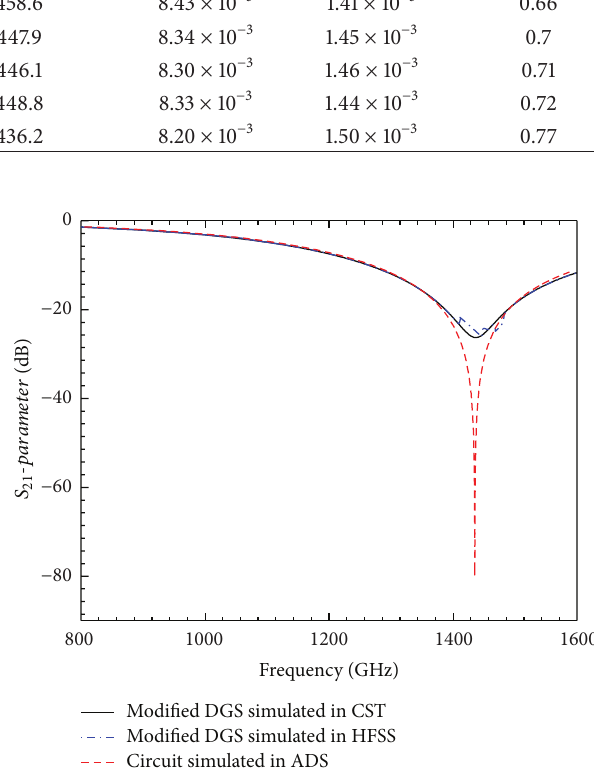
Figure 5: Comparison of the proposed modified DB-DGS bandstop filter in various EM simulated